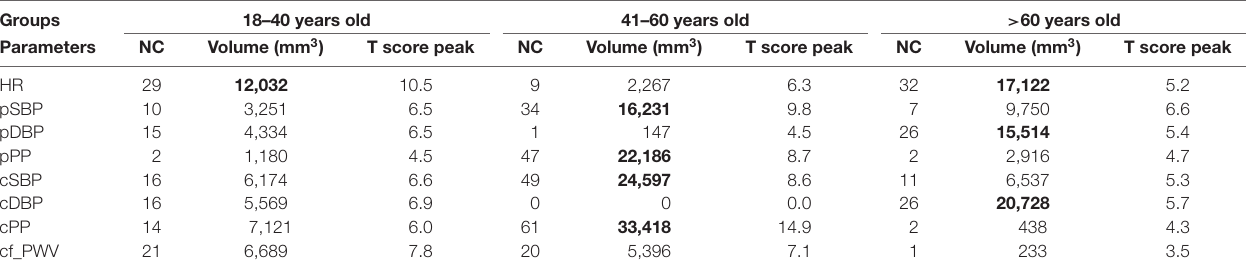
TABLE 3 | Results of the quantitative voxel-to-voxel analyses for the linear regression analyses between hemodynamic parameters and brain glycolytic metabolism on the three age groups ( p -voxel = 0.005, uncorrected, corrected for the cluster volume).